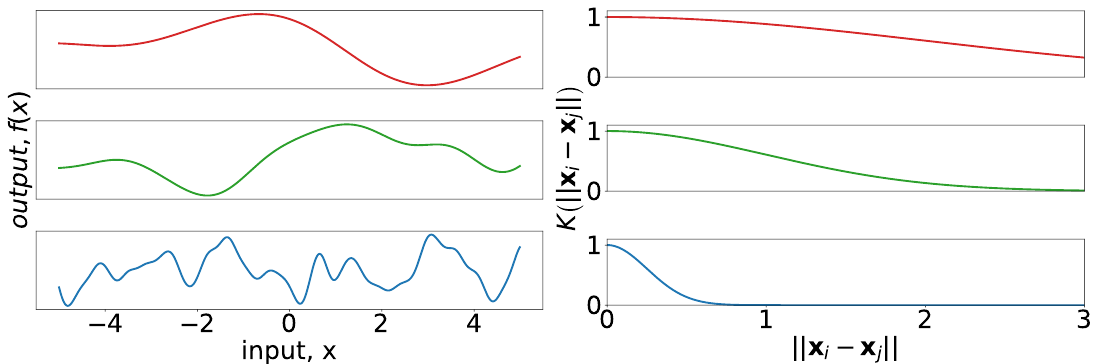
Figure 5. ( left ) Random draws from Gaussian processes with covariances defined by three different Gaussian kernels. In all cases, the amplitude is 1. The length-scales are 2, 1, 0.5 for top, middle, and bottom, respectively. ( right ) Covariance kernels corresponding to the cases on the